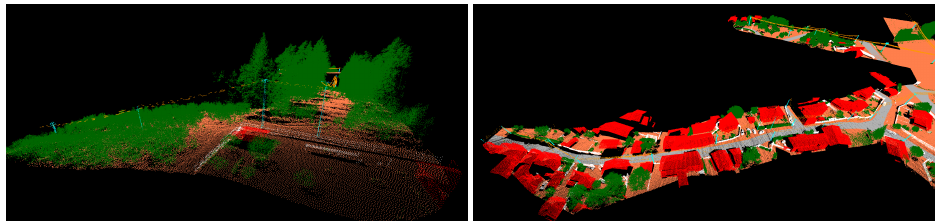
Figure 1. Urban area point cloud sample used to depict various features behaviors, colorized using orthophoto images.